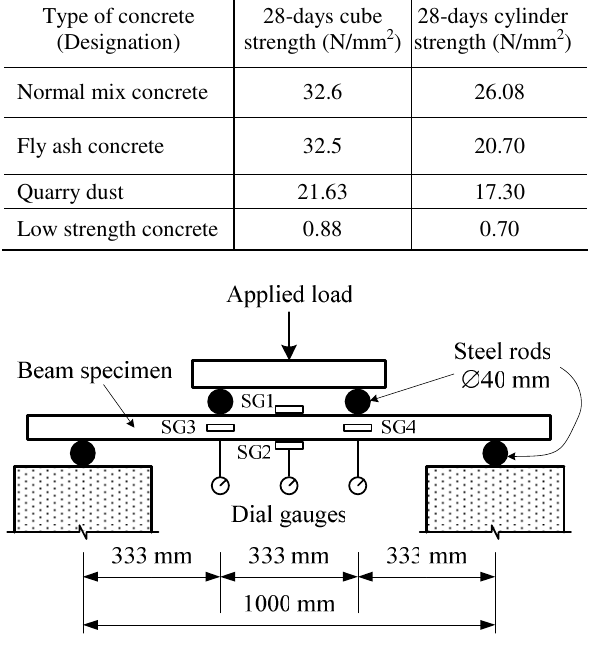
Fig. 2. Details of loading system for beam specimens